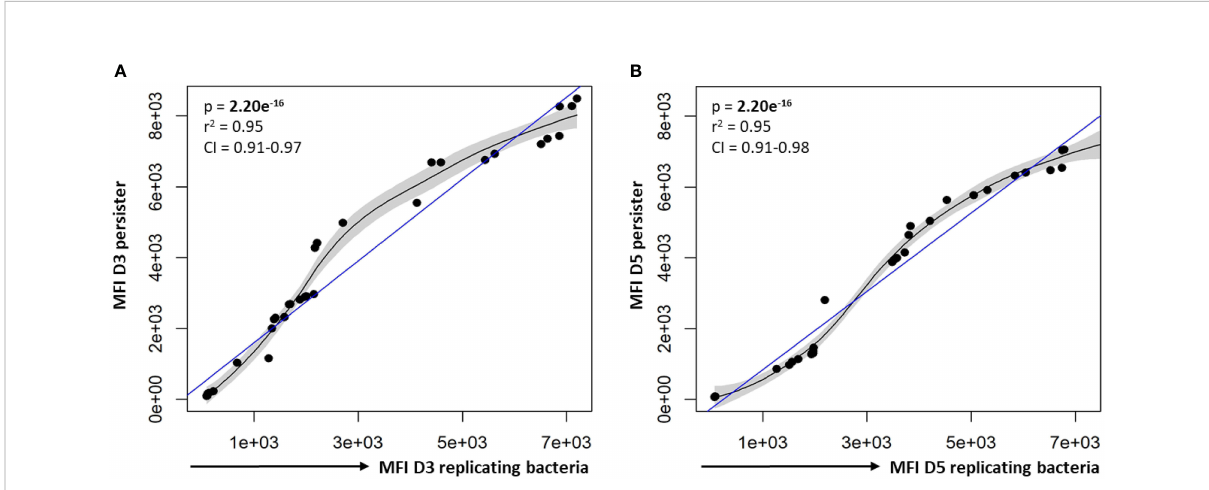
FIGURE 8 Correlation between the esterase activity of actively replicating bacteria and persisters. The esterase activity of intracellular bacteria was assessed following CV-AM staining and fl ow cytometric analysis. Signi fi cant positive correlations were observed between the esterase activity of actively replicating bacteria and persisters at (A) day 3 and (B) day 5. Data was assessed using the Pearson ’ s product-moment correlation (linear) and is representative of data independently conducted in 7 biological experiments, including technical triplicates. Signi fi cant p-values (p < 0.05) are shown in bold. The blue line represents the regression line for the correlation analyses (Pearson), while the black line and associated shaded area represents the local non-linear regression and 95% con fi dence interval. r 2 , Pearson ’ s correlation coef fi cient squared; CI, 95% con fi dence interval; MFI, median fl uorescent